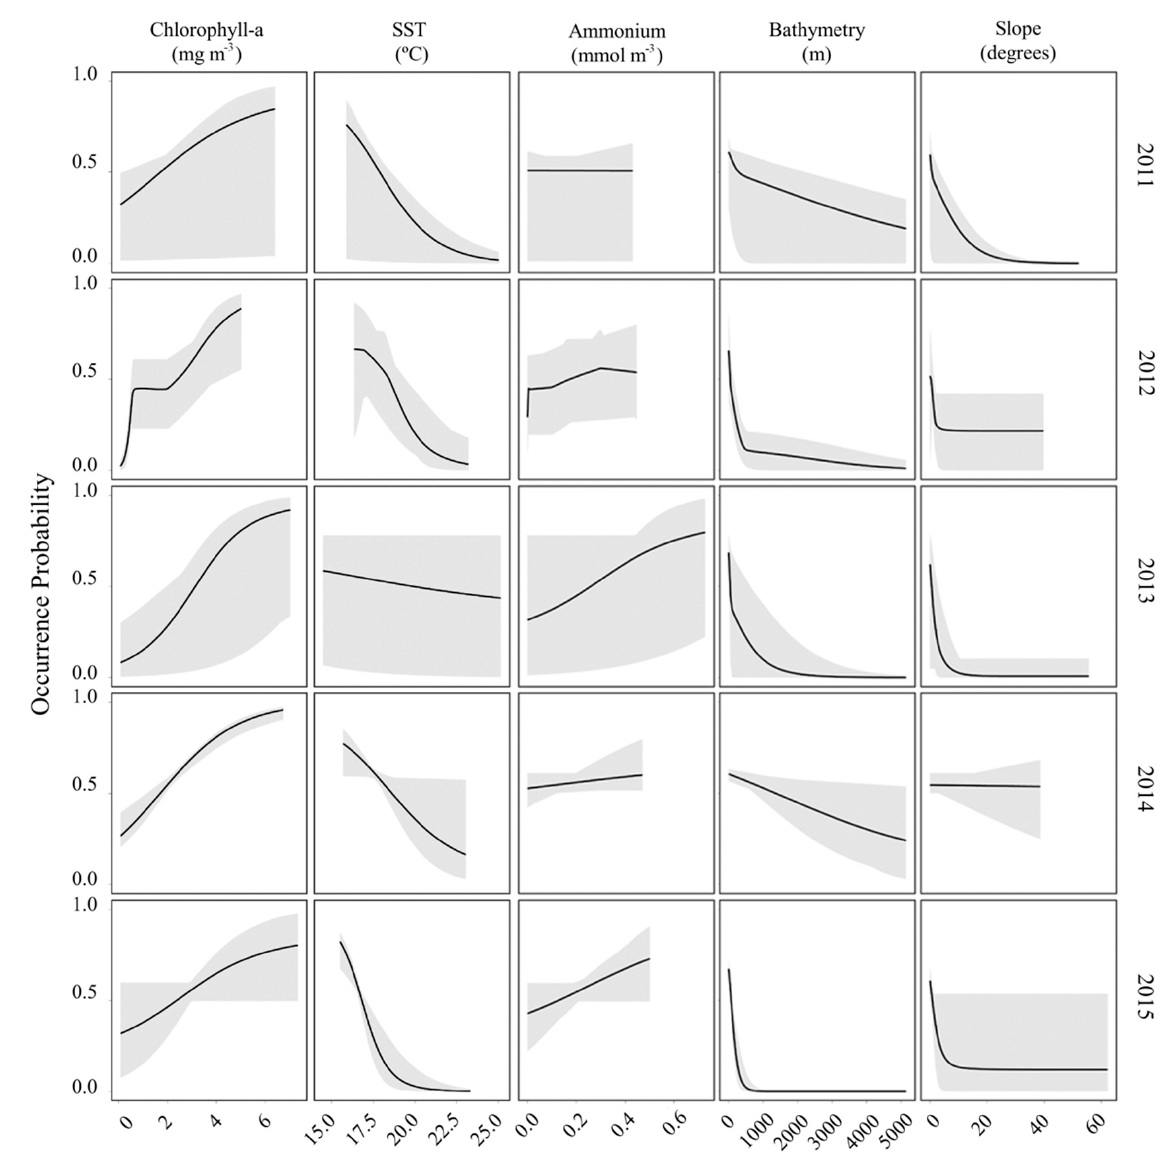
Figure 4. Harbour porpoise occurrence probability response curves in relation to the EGVs included in the ESMs in the study area and extent area during September 2011, 2012, 2014, and 2015 and October 2013. Mean (black lines) and minimum and maximum values (grey areas) of 10 replicates are shown.